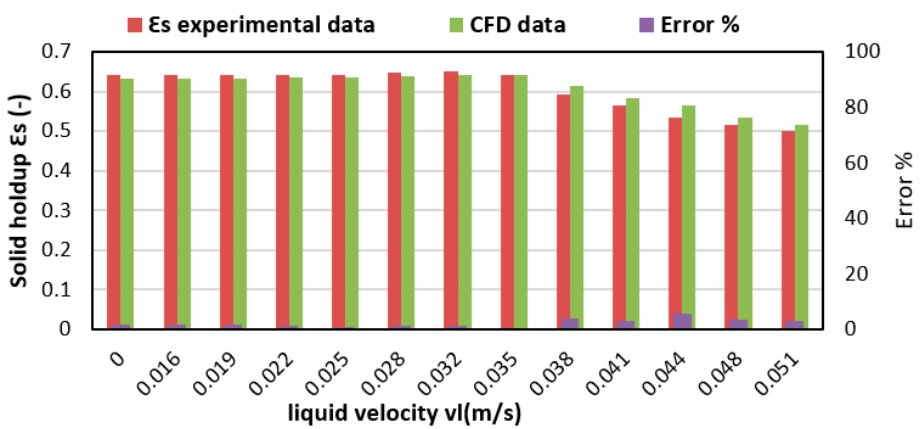
Figure 11. Comparisons between CFD simulation results and experimental data of solid holdup for particles with a diameter of 3 mm for different superficial liquid velocities.